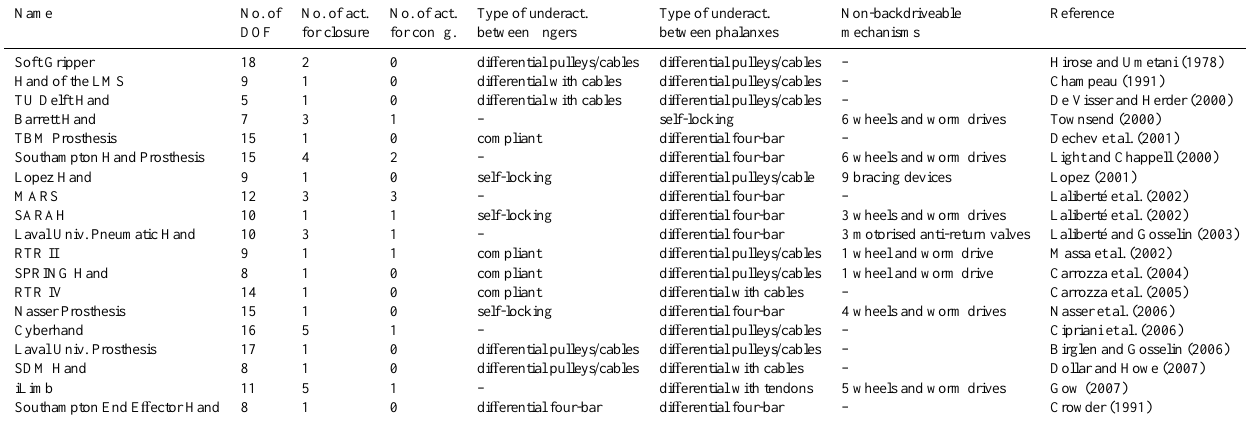
Table 1. Characteristics of underactuated robotic hands. The symbol – indicates that there is no underactuation or no non-backdriveable mechanisms depending on the